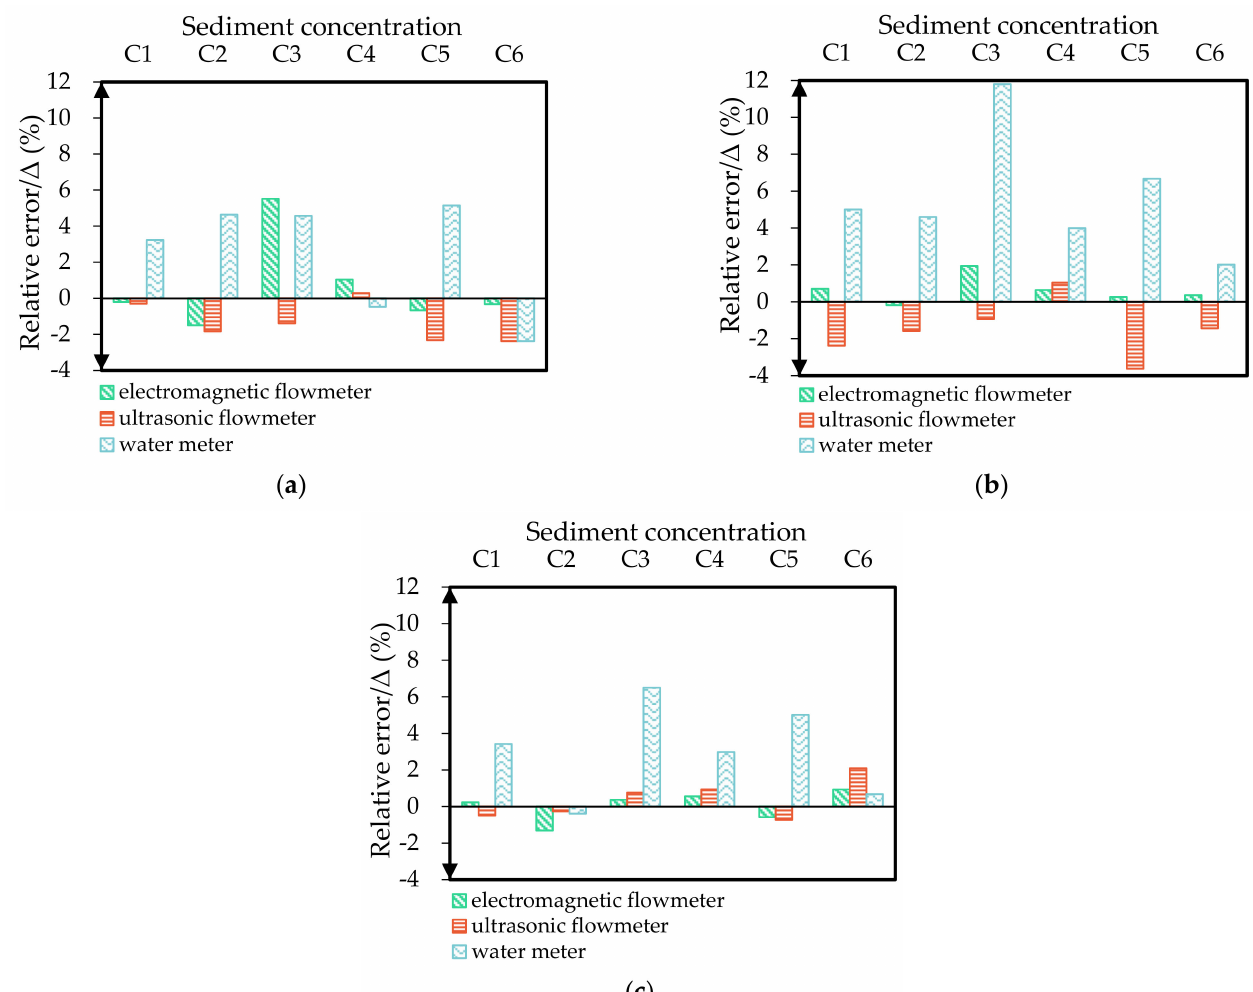
Figure 4. The relative error between each measuring device and the right triangle weir. ( a ) 1.0 m/s; ( b ) 1.25 m/s; ( c ) 1.5